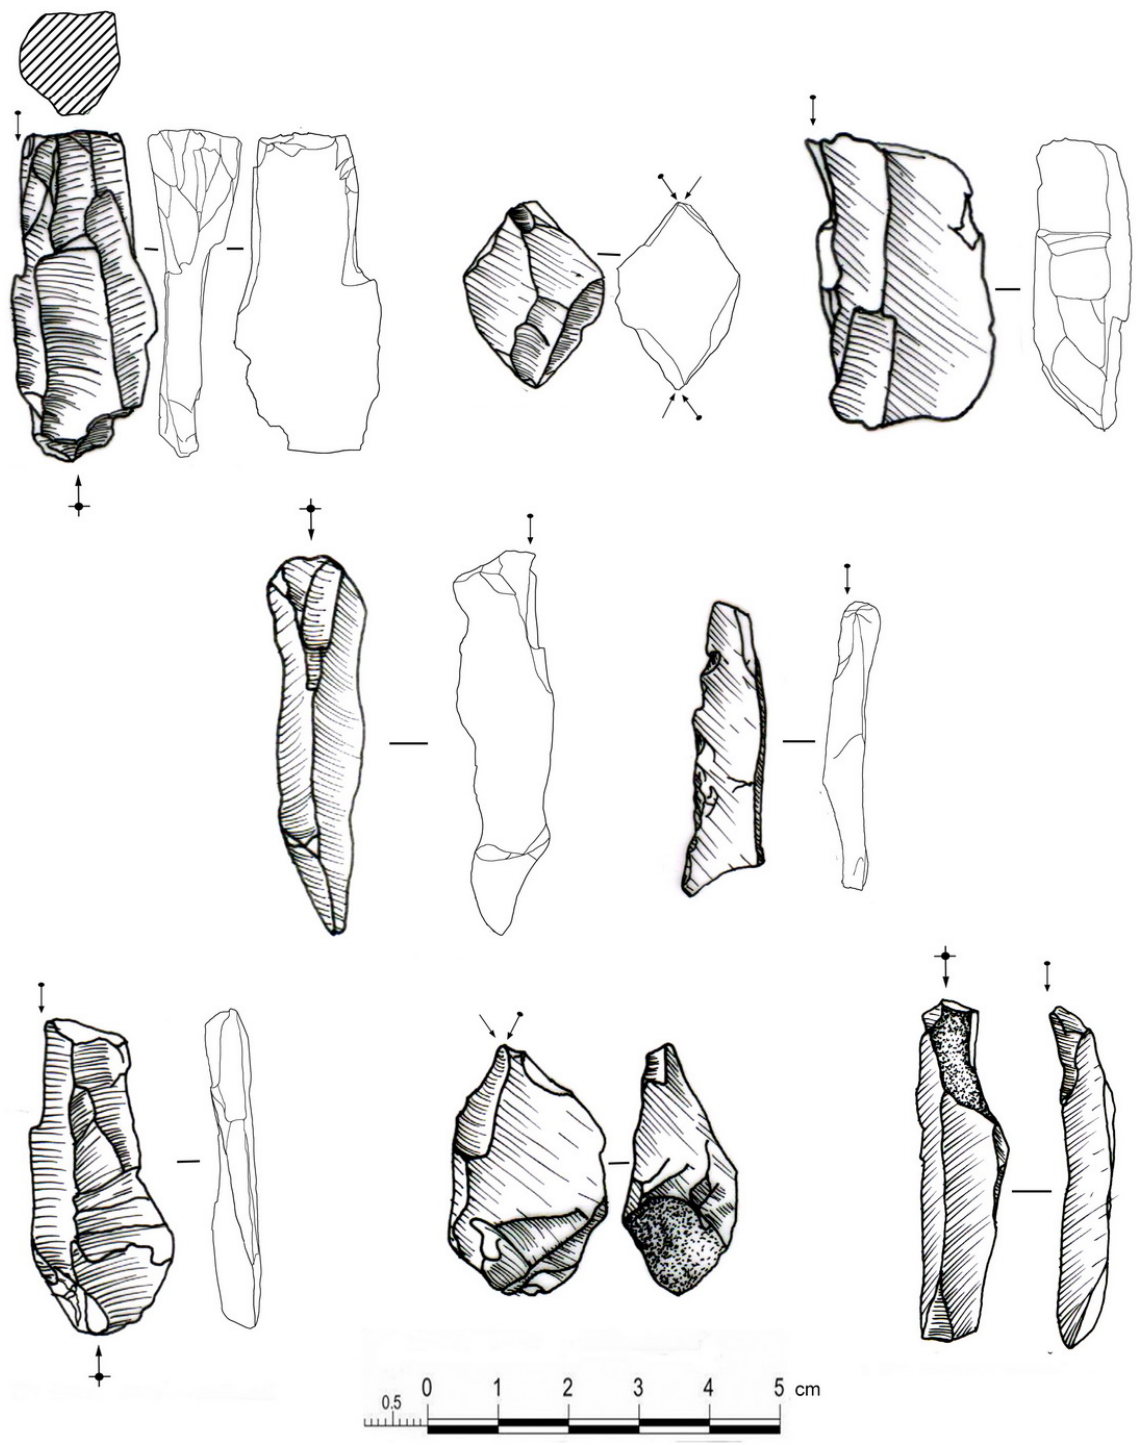
Figure 15. Collection of burins located at Tajo de